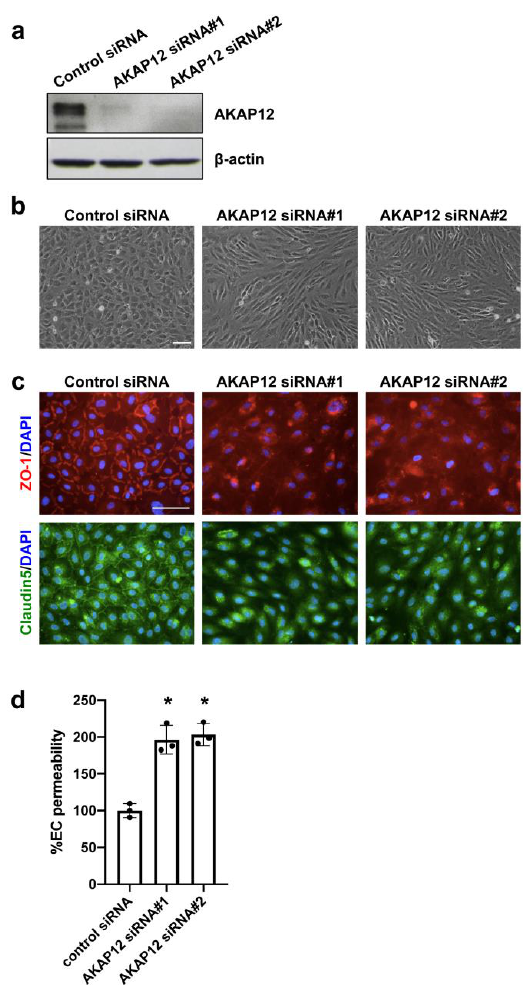
Figure 3. AKAP12 and in vitro endothelial permeability: ( a ) In cultured cerebral endothelial